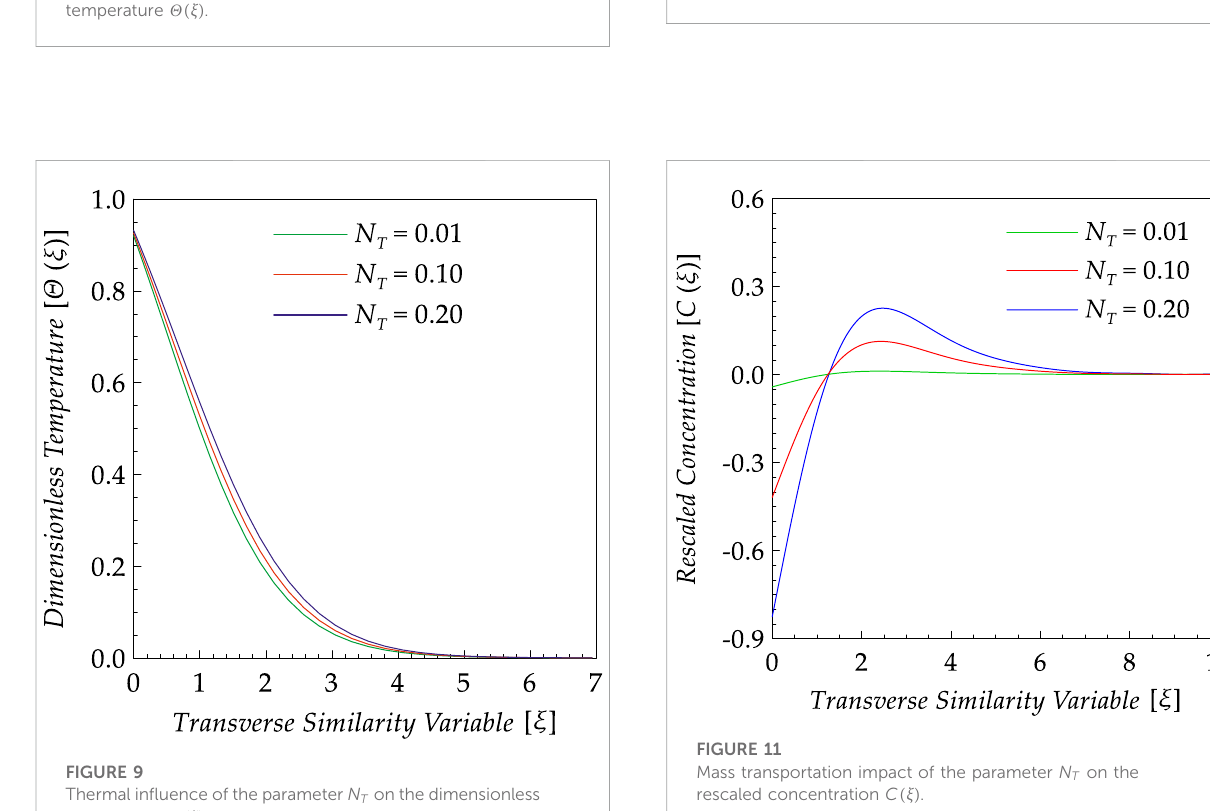
FIGURE 10 Mass transportation impact of the parameter Bi on the rescaled concentration C ( ξ )